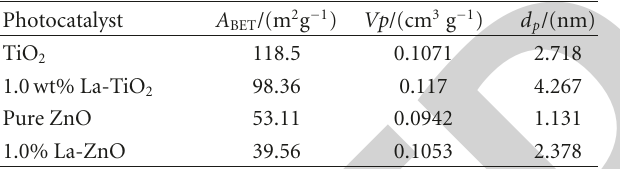
Table 2: Textural properties of pure and La-doped